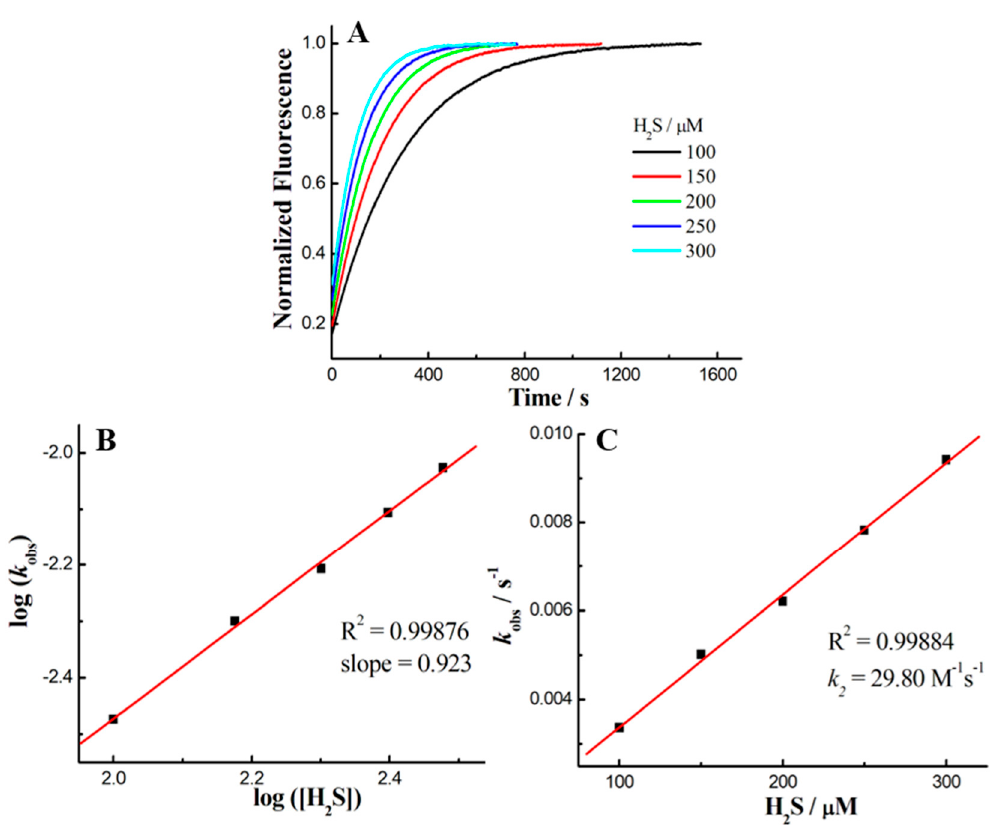
Figure 2. ( A ) The time-dependent fluorescence intensities at 660 nm for 1 (2 µM) in the presence of different concentrations of H 2 S in PBS (50 mM, pH 7.4, containing 10% DMSO). ( B ) The linear relationship of log(k obs ) versus log([H 2 S]). ( C ) The linear relationship of k obs versus H 2 S concentrations.